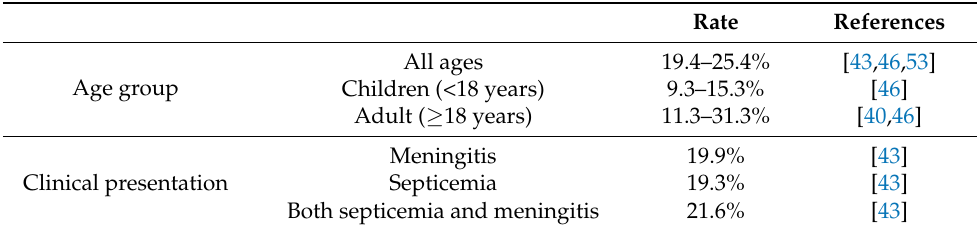
Table 3. Proportion of patients with at least one sequela associated with invasive meningococcal disease by age